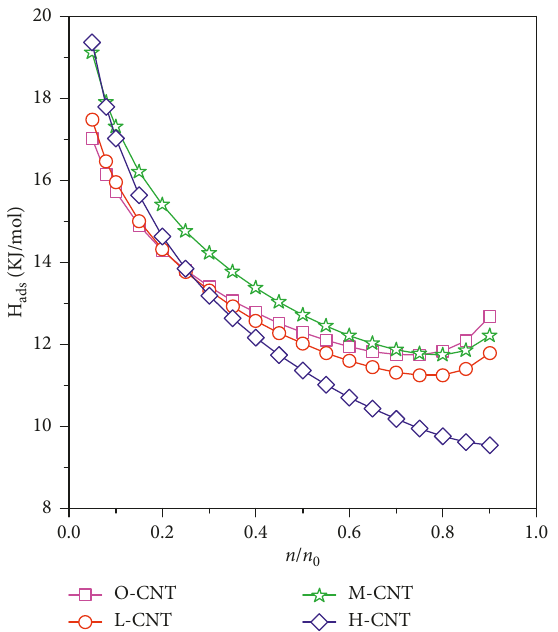
Figure 9: Heat of adsorption ( H n / n loadings 0 ) at (